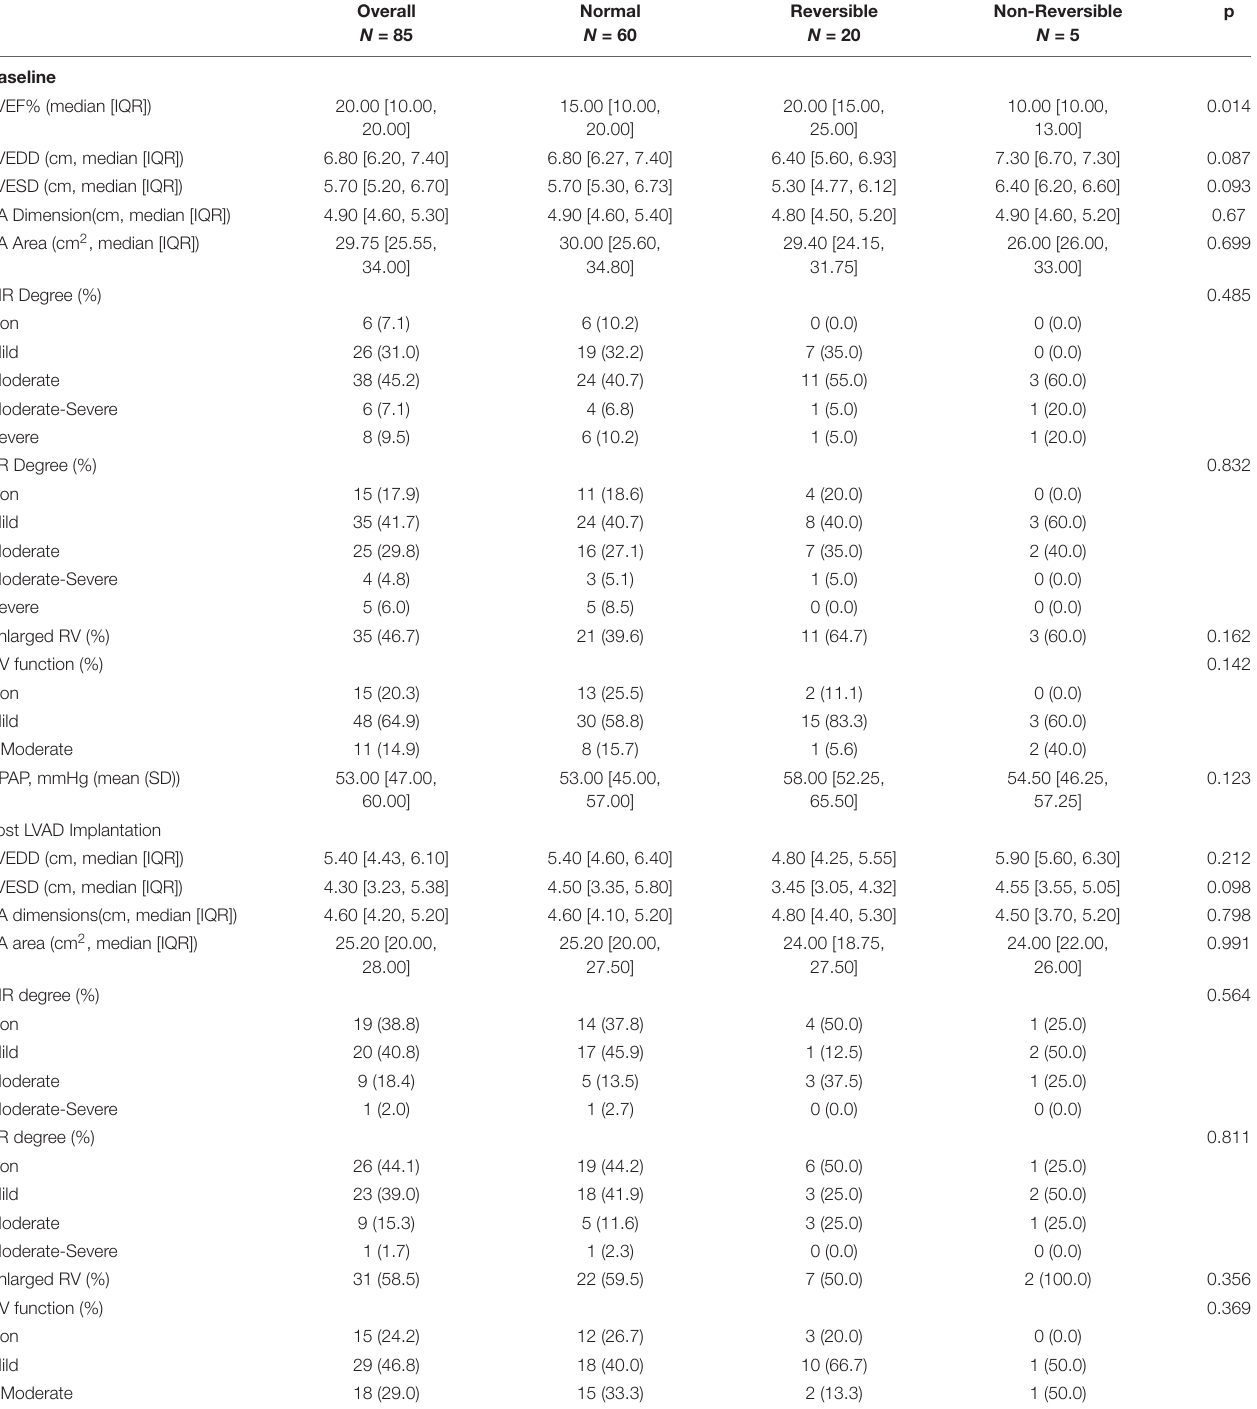
Non-Reversible N = 5